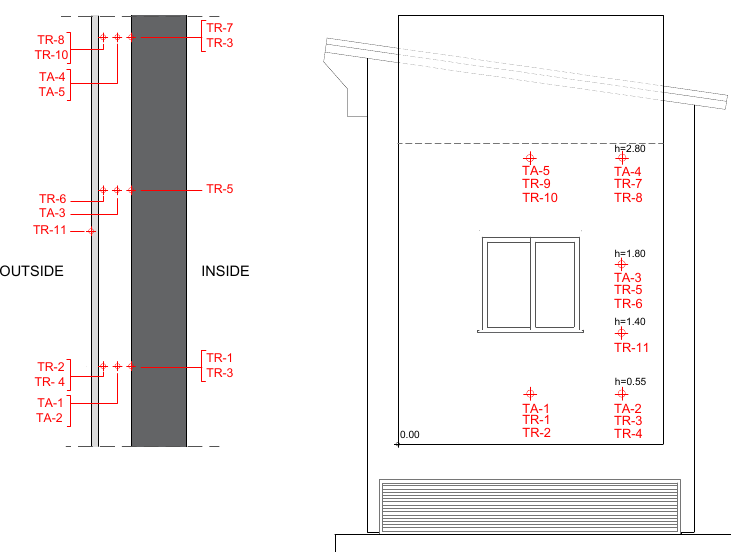
Figure 3. Position of the monitoring sensors in the OVF. TR: surface temperature sensors, TA: air velocity and temperature sensors (h indicates the height in meters).